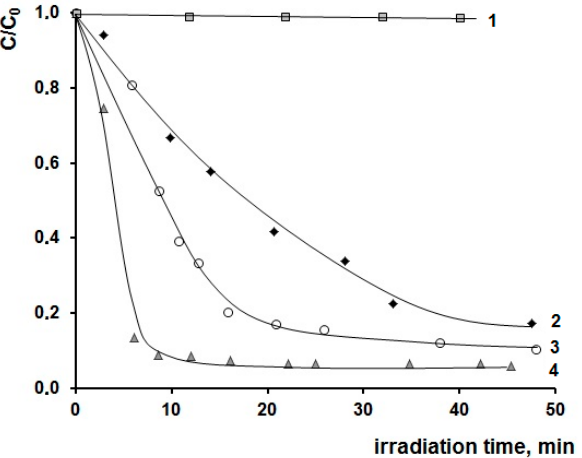
Figure 8. Changes in concentration of p-NP in solutions during their irradiation with light > 410 nm (light filter «ZhS-11») in the presence of nanocomposites [( ≡ TiO) n ]:[HEMA] [M]: curve 1—«empty» experiment; curve 2—BMA + Ag NPs, curve 3—HEMA + Ag NPs; curve 4—AN + Ag NPs. experiment; curve 2—BMA + Ag NPs, curve 3—HEMA + Ag NPs; curve 4—AN + Ag NPs.